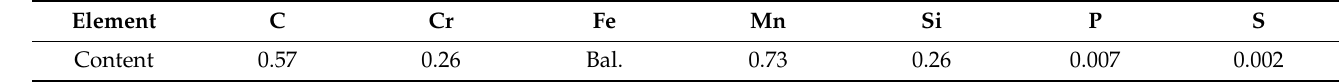
Table 1. Chemical compositions of ER9 (wt%).